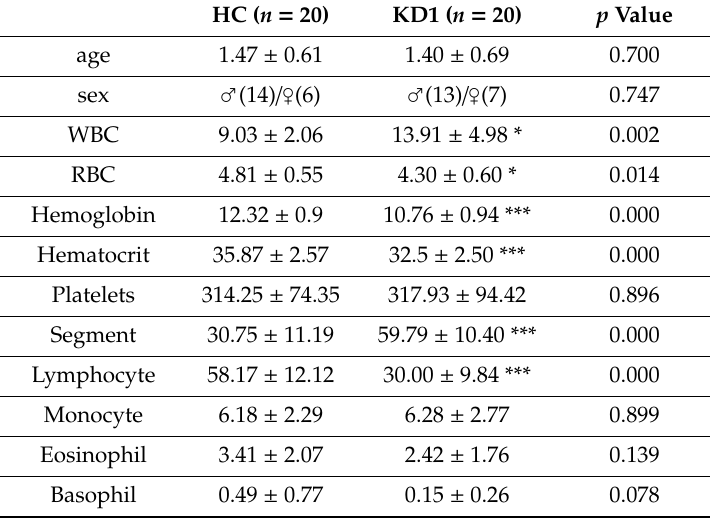
Table 2. Demographic and Clinical Characteristics of Enrolled Patients.